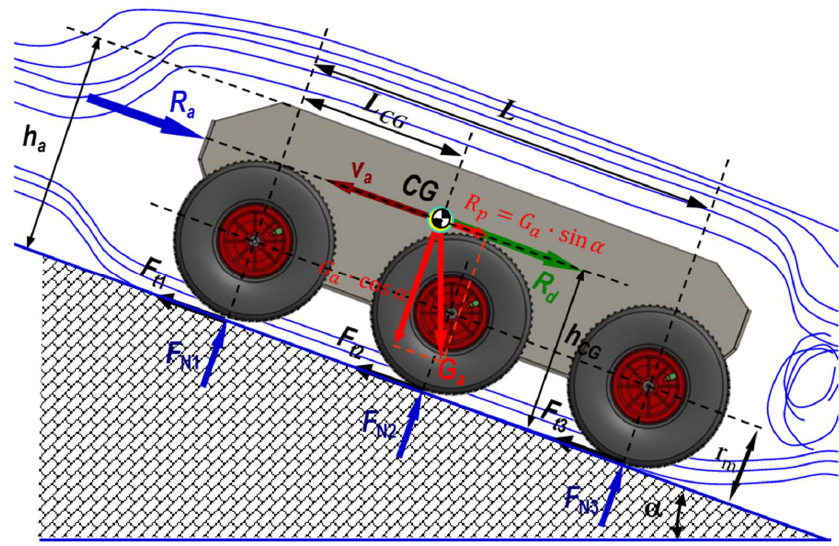
Figure 7. A schematic of the 3D dynamics of the 6 × 6 robot showing the elements that influence the dynamic characteristics of a land vehicle: air resistance, friction force, robot weight, center of gravity position, wheel radius, and slope angle. The following figures will highlight other elements that contribute to influencing the law of motion of the robot.